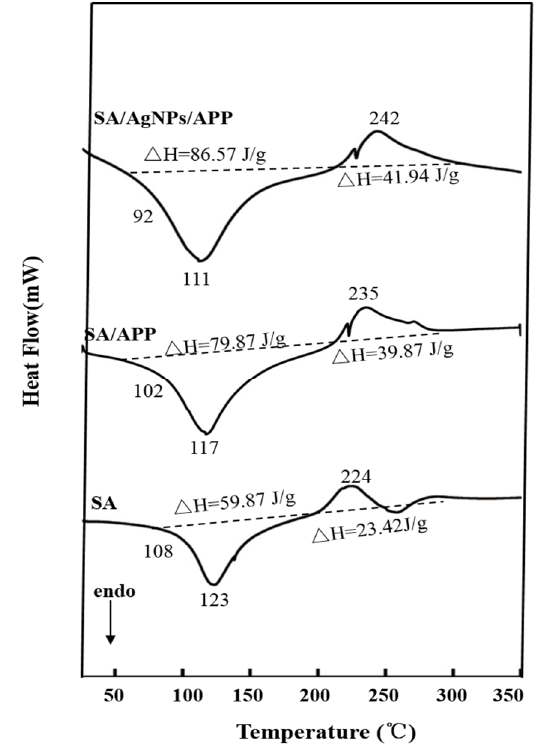
Figure 6. DSC of SA, SA/APP and SA/AgNPs/APP composite films.